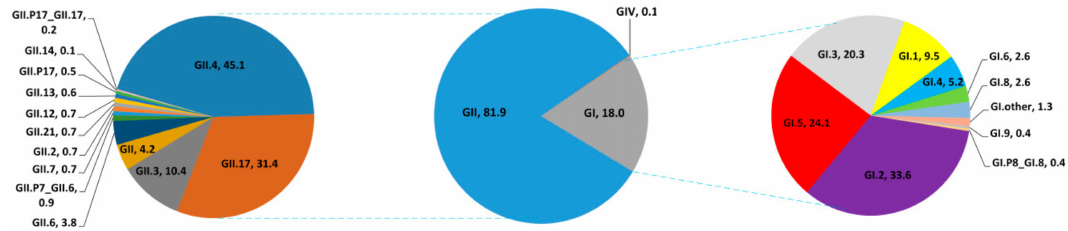
Figure 4. Genogroups and genotypes percentage of 1291 sequences of noroviruses isolated from 15 provinces and areas in China during 2004 to 2015. The pie in the figure was generated by the number of sequences ( n =